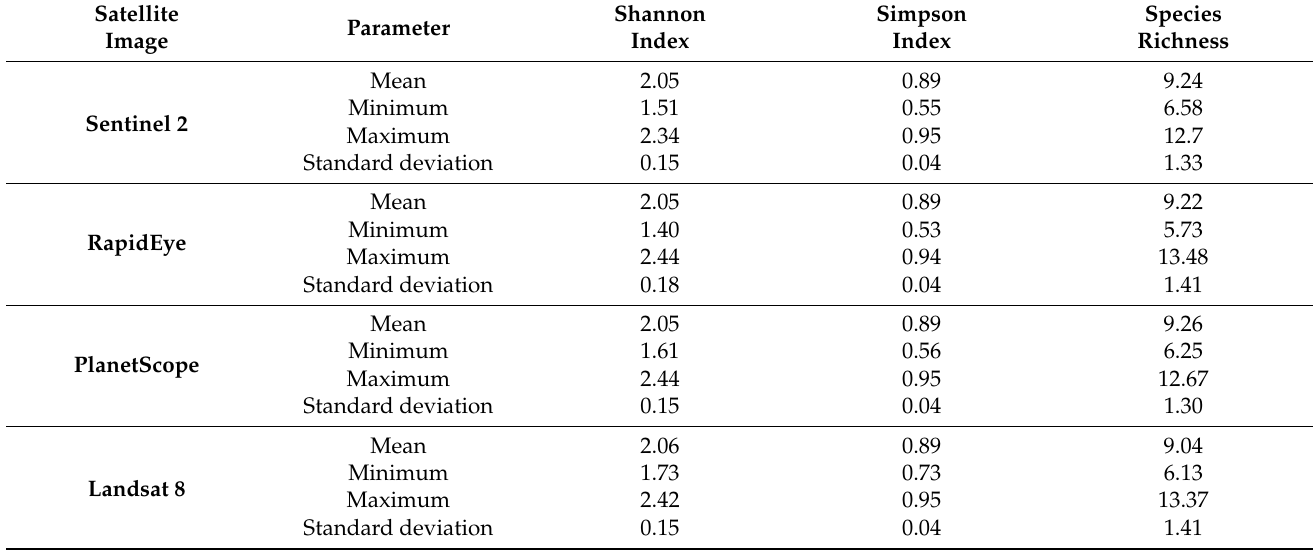
Table 4. The statistical analysis of the prediction made with the RF for each of the images under the Shannon Index, Simpson Index and the Species richness.